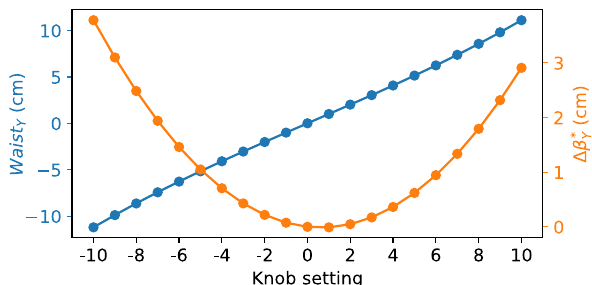
FIG. 12. Simulated effect on the design model with β (cid:1) ¼ 30 cm optics of one of the waist displacement knobs experimentally tested in the LHC. The blue line represents the waist displacement and is almost completely linear with the knob value. The orange line shows the β (cid:1) following the parabola of Eq. (2) as the waist is displaced. The minimum of the parabola is not at the zero knob setting because the design optics includes a small